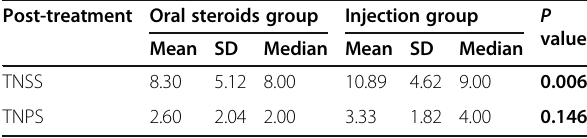
Table 2 Total nasal symptoms score (TNSS) and total nasal polyps score (TNPS) in both groups after receiving treatment Post-treatment Oral steroids group